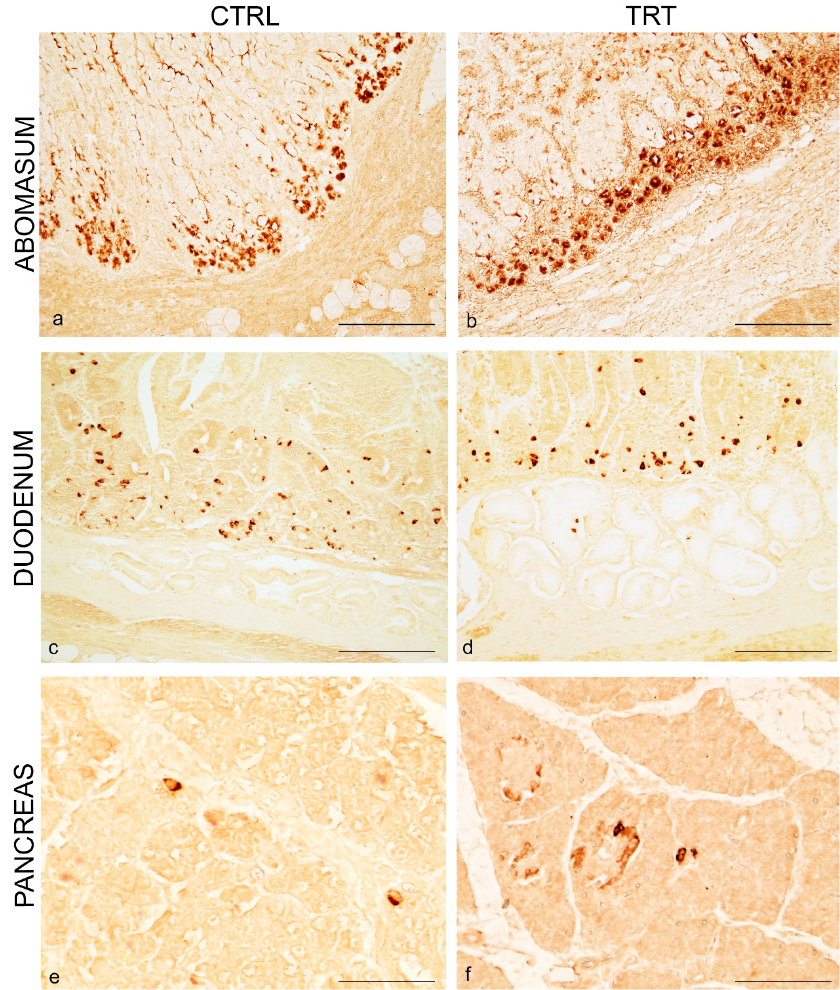
Figure 2. 5-HT immunoreactivity in the abomasum, duodenum and pancreas of control and treated goat kids. Numerous positive cells in the glands at the basis of gastric epithelium of control ( a ) and ANTs fed animals ( b ). Overview of 5-HT distribution in neuroendocrine cells ( c ) in the crypt of Lieberkühn of duodenum of control ( c ) and ANTs fed animals ( d ). Overview of 5-HT distribution in scattered cells in the pancreatic parenchyma of control ( e ) and ANTs fed animals ( f ). Scale bar: (a,b,f) = 50 μm; (c,d) = 100 μm; (e) = 25 μm.